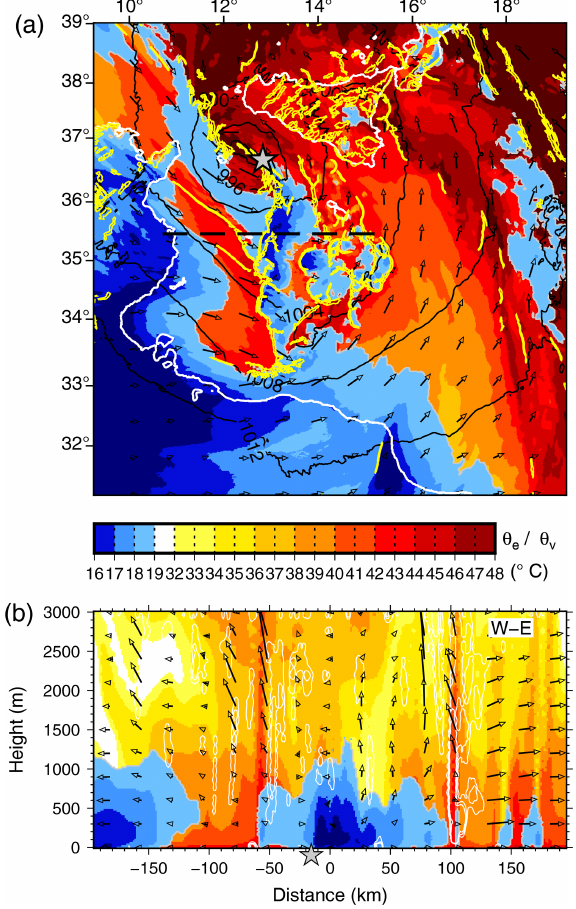
Figure 11. Map of equivalent potential temperature (warm colours) and virtual potential temperature below 19 ◦ C (blue shades) at first level; horizontal convergence rate above 1 × 10 − 3 ms − 2 at 100m (yellow contours), 10m wind (arrows) and SLP (black contours) at 08:30UTC on 7 November (a) ; and vertical cross section of equiva- lent potential temperature and virtual potential temperature (colour scale), tangential wind (black vectors; the vertical component is am- plified by a factor 20), and potential vorticity anomaly (white con- tour at 5PVU) along a west–east transect (b) (dashed line in a ). Grey stars indicate the position of the SLP minimum.